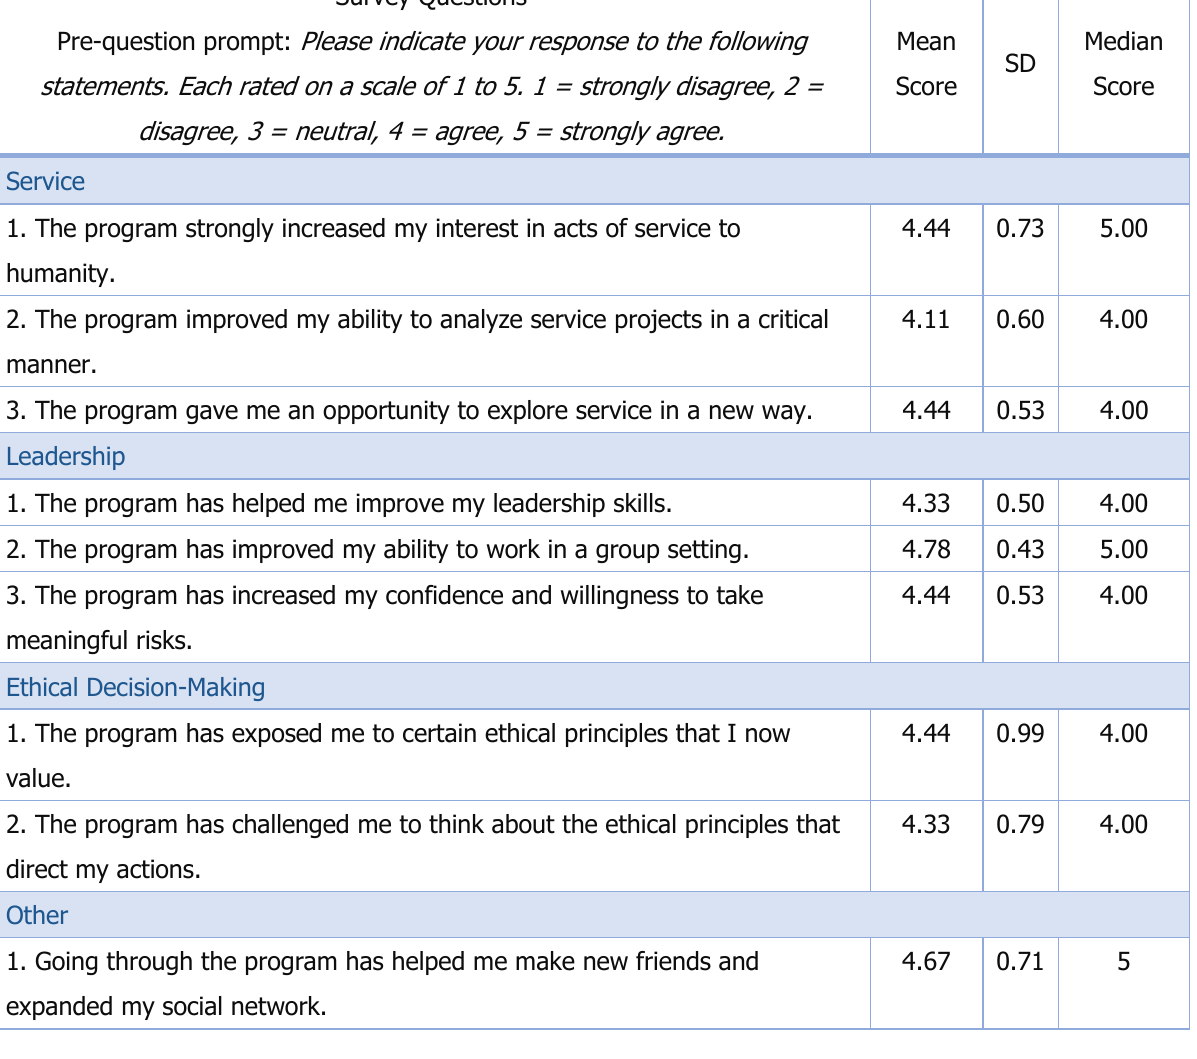
Table 1. Survey Questions and Response Mean, Median, and Standard Deviation Survey